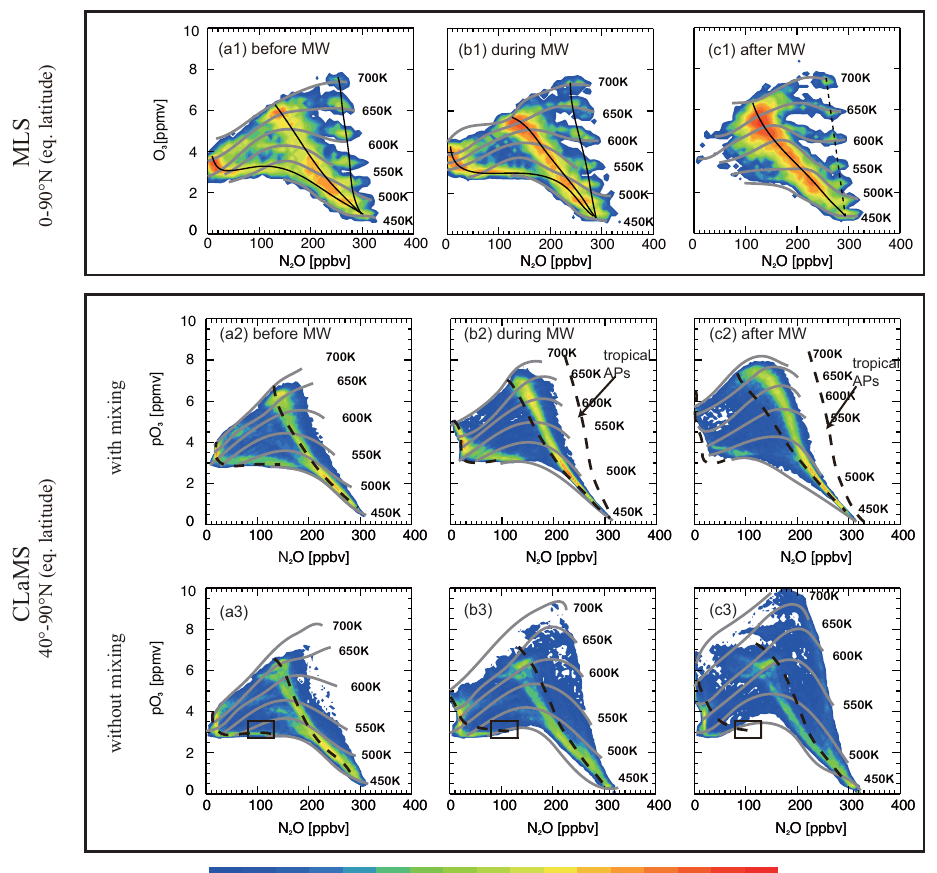
Figure 9. PDFs of N 2 O–O 3 correlations (tracer space) shown for three periods: (a) 18–28 December, (b) 18–28 January and (c) 18–28 February. The top row (a1–c1) is based on the MLS observations within eq. latitudes 0–90 ◦ N and potential temperature range between 450 and 700K. The black lines in (a1–c1) represent the respective correlation branches (polar, surf-zone, tropics). The middle and bottom rows show CLaMS simulations without ozone chemistry but with and without mixing, respectively. CLaMS PDFs are calculated from the APs with the same potential temperature range but with eq. latitudes between 40 and 90 ◦ N. The grey lines mark the isentropes (450, 500, 550, 600, 650, and 700K). For better comparison between CLaMS with and without mixing, the dashed black curves in (a2–c2) show the estimated N 2 O–O 3 correlation line from the case without mixing (i.e. from a3–c3). Reversely, dashed lines in (a3–c3) depict schematically transferred correlation branches from CLaMS with mixing (i.e. from